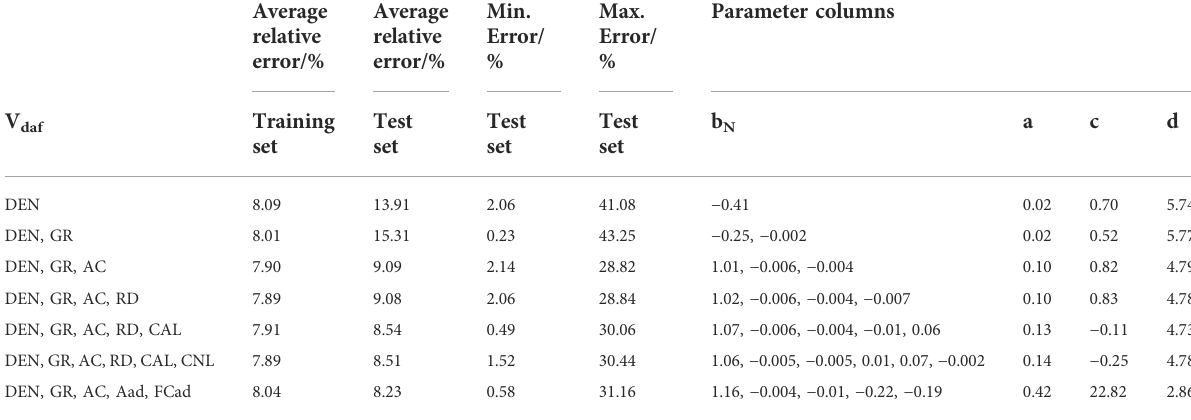
TABLE 4 Performance and parameters of the Vd af content prediction models under different logging